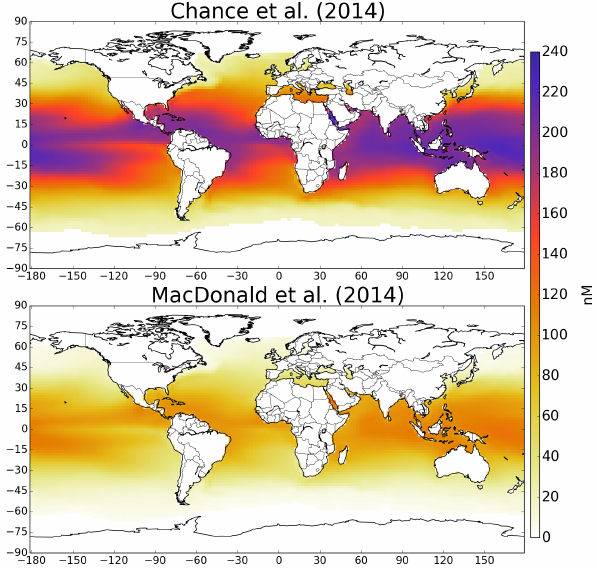
Figure 16. Calculated annual mean ocean surface iodide concen- trations (I − ) in nM. Values are calculated from the highest corre- lation relationship (square) presented in Table 2 of Chance et al. (2014) (top panel) and from the Arrhenius relationship from Eq. (1) in MacDonald et al. (2014) (bottom panel). The Chance et al. (2014) parametrization is used as the standard in the work with the Mac- Donald et al. (2014) used as the “Ocean iodide” sensitivity simula- tion in Sect.